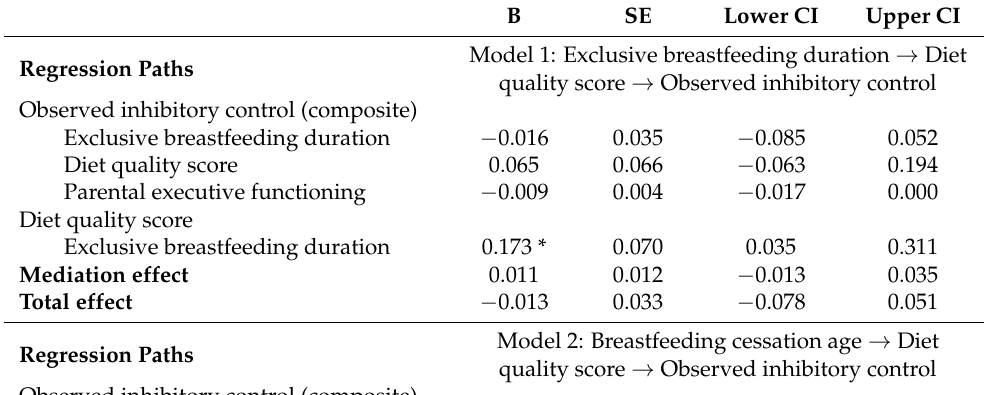
Table 4. Parameter estimates and bootstrapped confidence intervals for Model 1, 2, 3, and